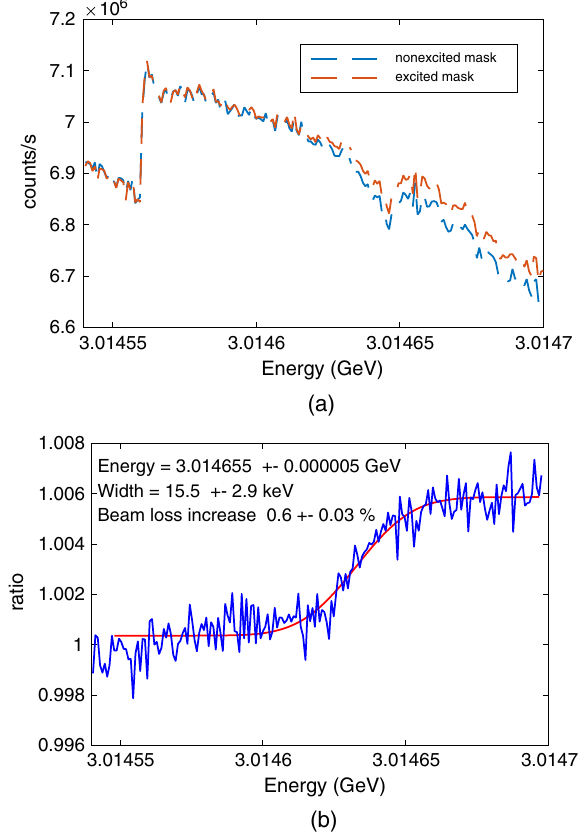
FIG. 6. The ratio of the beam loss data from the two masks show the beam